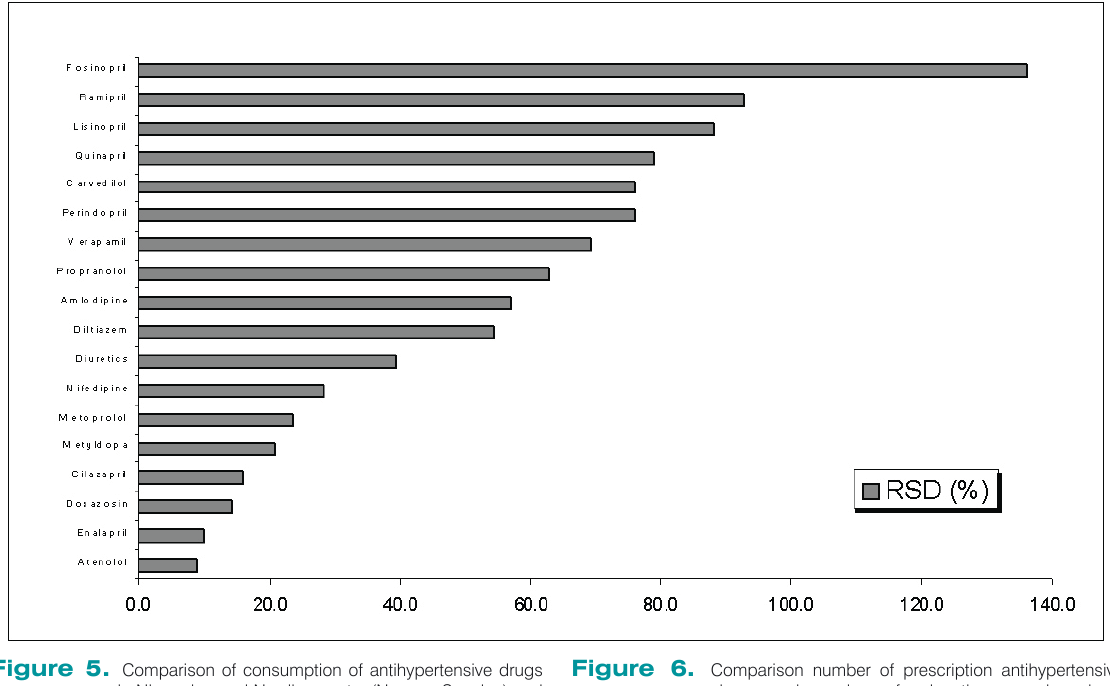
Figure 4. Relative standard deviation (RSD) per antihypertensive